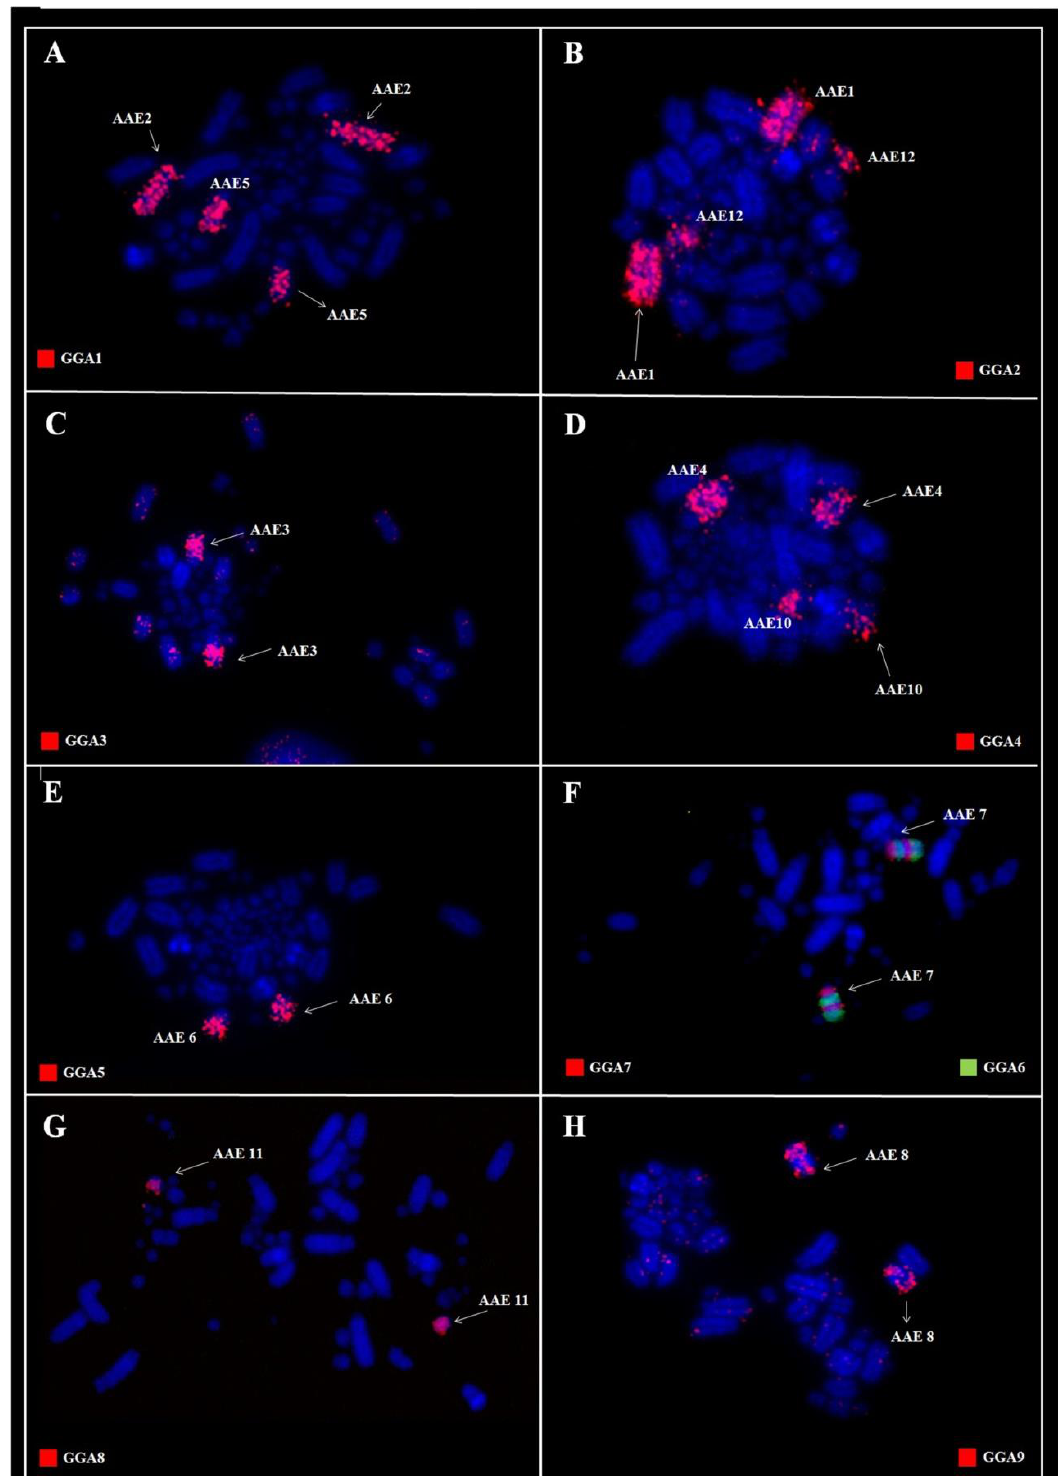
Figure 5. Fluorescent in situ hybridization with whole-chromosome probes of G. gallus 1 – 9 in A . aestiva . AAE: Amazona aestiva.